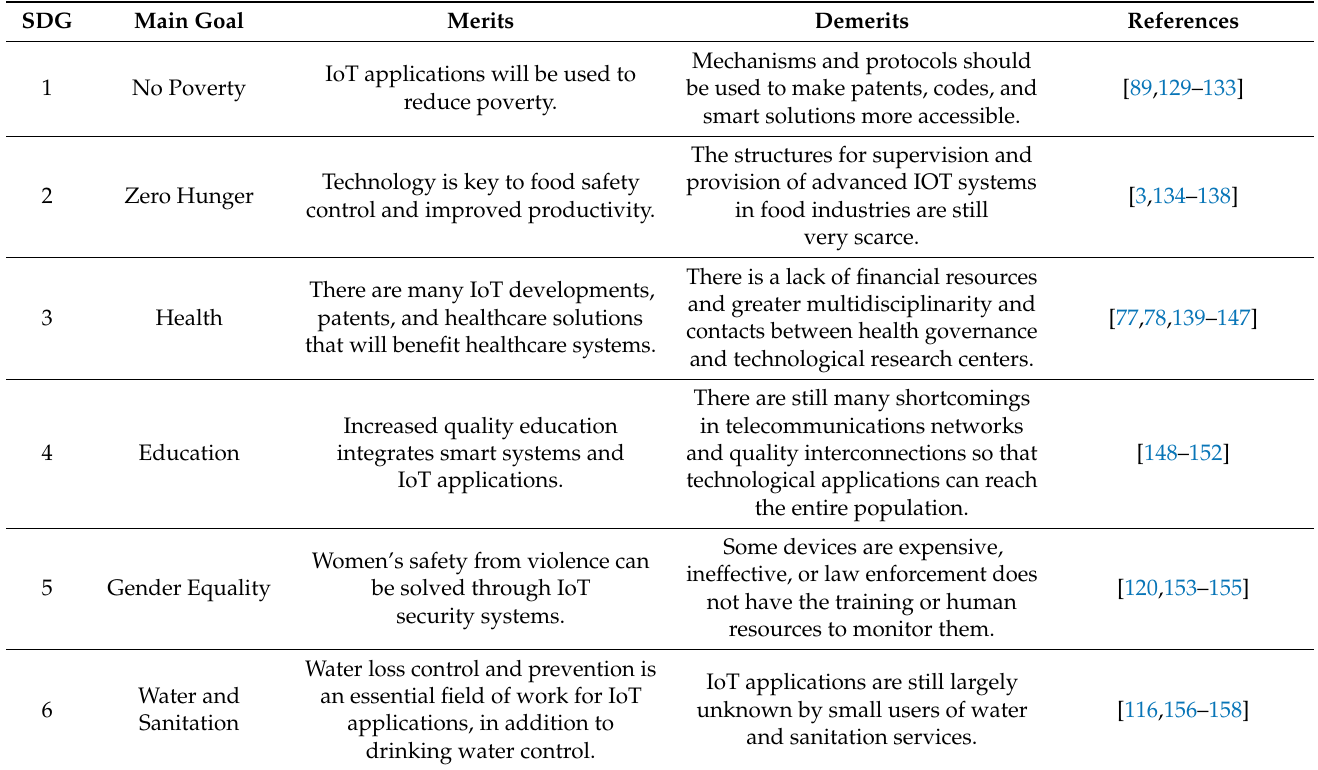
Table 6. Merits and demerits of SDGs and Application to IoT